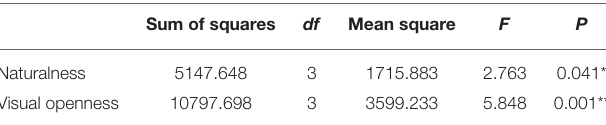
TABLE 3 | Difference between the TMD values for landscape naturalness and visual